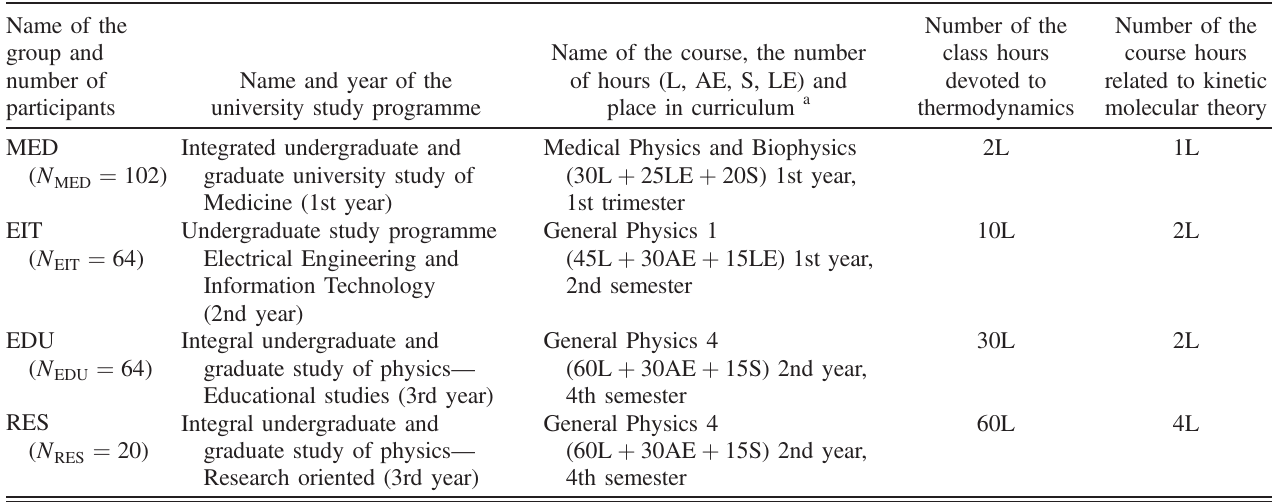
TABLE III. Description of subgroups ’ curricula related to thermodynamics. For each group we provide information about: the number of hours of lectures (L), auditory exercises (AE), seminars (S) or laboratory exercises (LE), number of class hours devoted to thermodynamics, number of class hours devoted to kinetic molecular